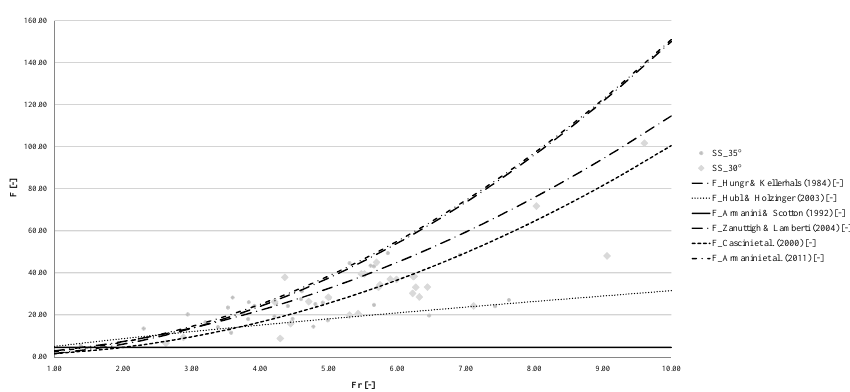
Figure 6. Trend of normalized force measured (points) and predicting model (line) in function of the Froude number. The labels SS_30 ◦ and SS_35 ◦ correspond to force values evaluated using saturated sand with an inclination of the flume of 30 ◦ (circle points) and 35 ◦ (diamond points), respectively.